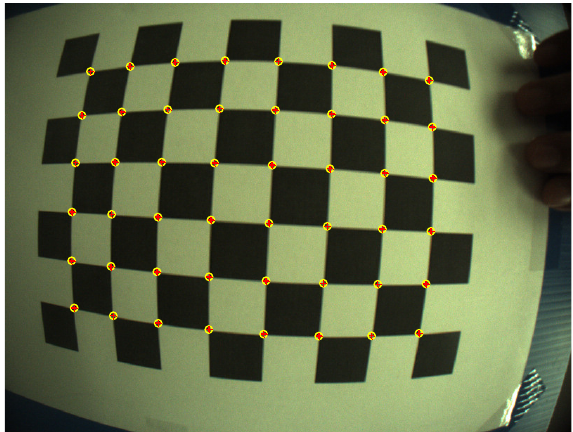
Figure 9: The re-projection of the corner points on calibration pattern on Ladybug 3 camera. The yellow circles are the de- tected corner points while the red plus sign the re-projected cor- ner points.